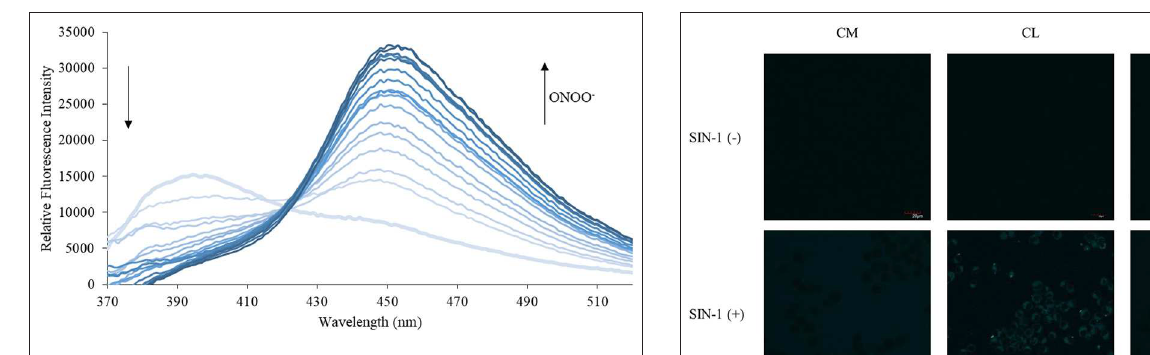
FIGURE 6 | Emission spectra for CL (5 µ M) in the presence of ONOO − (1, 2, 3, 4, 5, 6, 7, 8, 9, 10, 15, 20, 25, 30, 40, 50 µ M) in PBS buffer, pH = 7.4 at 25 ◦ C. Fluorescence intensities were measured with λ ex = 340 (bandwith: 20) nm on a BMG Labtech CLARIOstar ® plate reader.